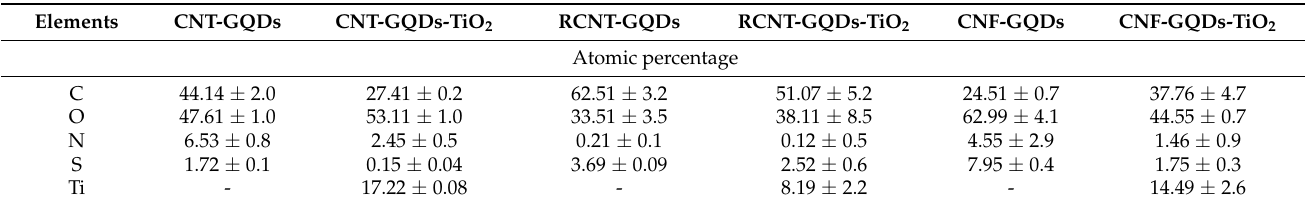
Table 1. Atomic percentage analysis with statistical error using XPS spectrometer for as-prepared GQDs and GQDs-TiO 2